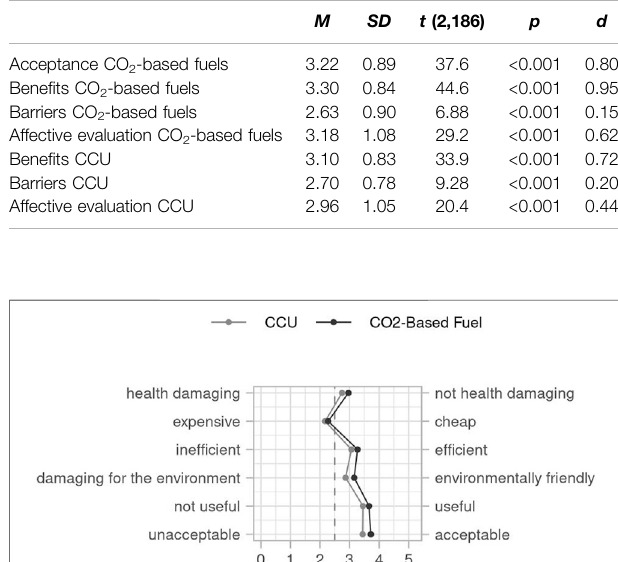
TABLE 1 | Descriptive statistics and results of one sample t-test with 2.5 for the evaluation of the constructs for CCU and CO 2 -based fuels.